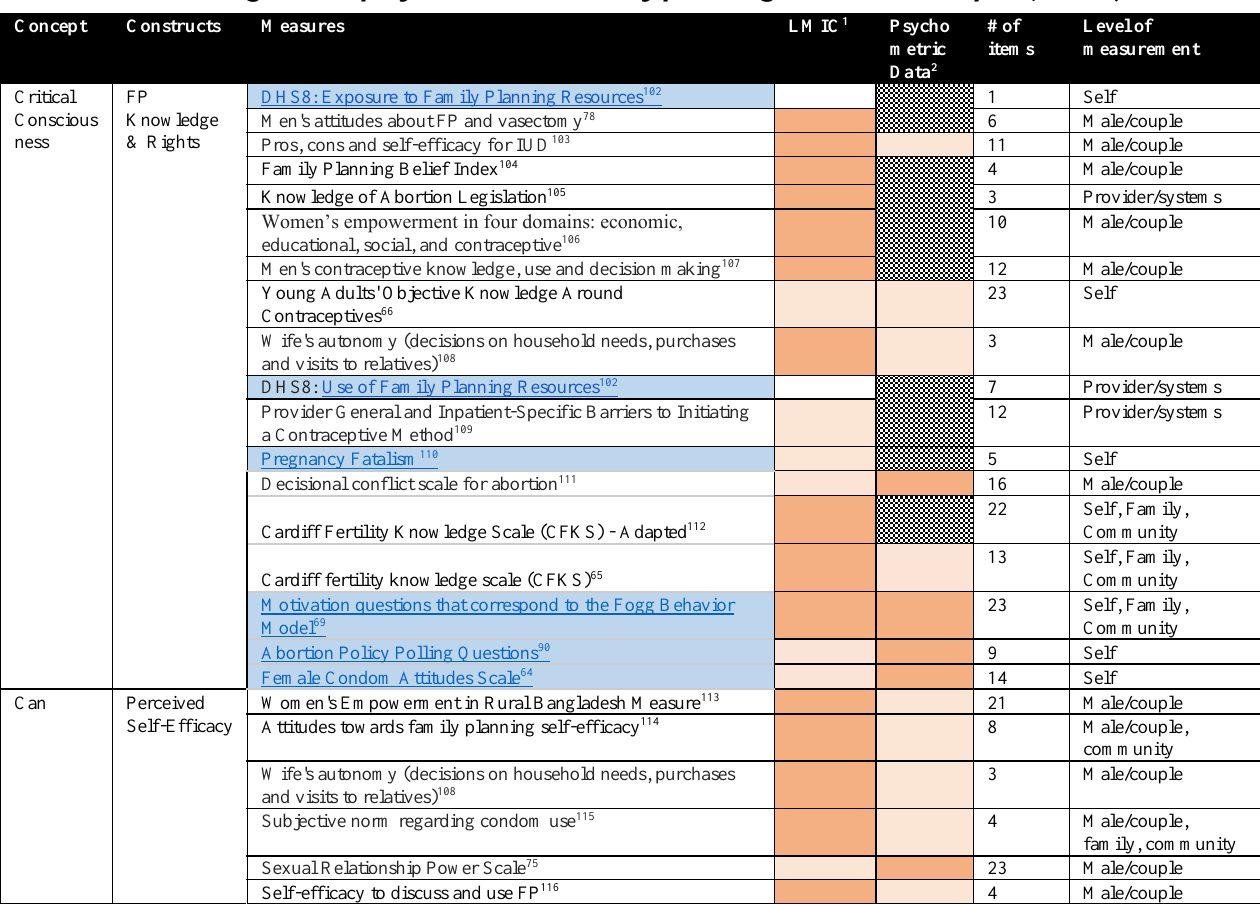
Table 5: Full list of gender equity measures in family planning in the White Paper (n=223)